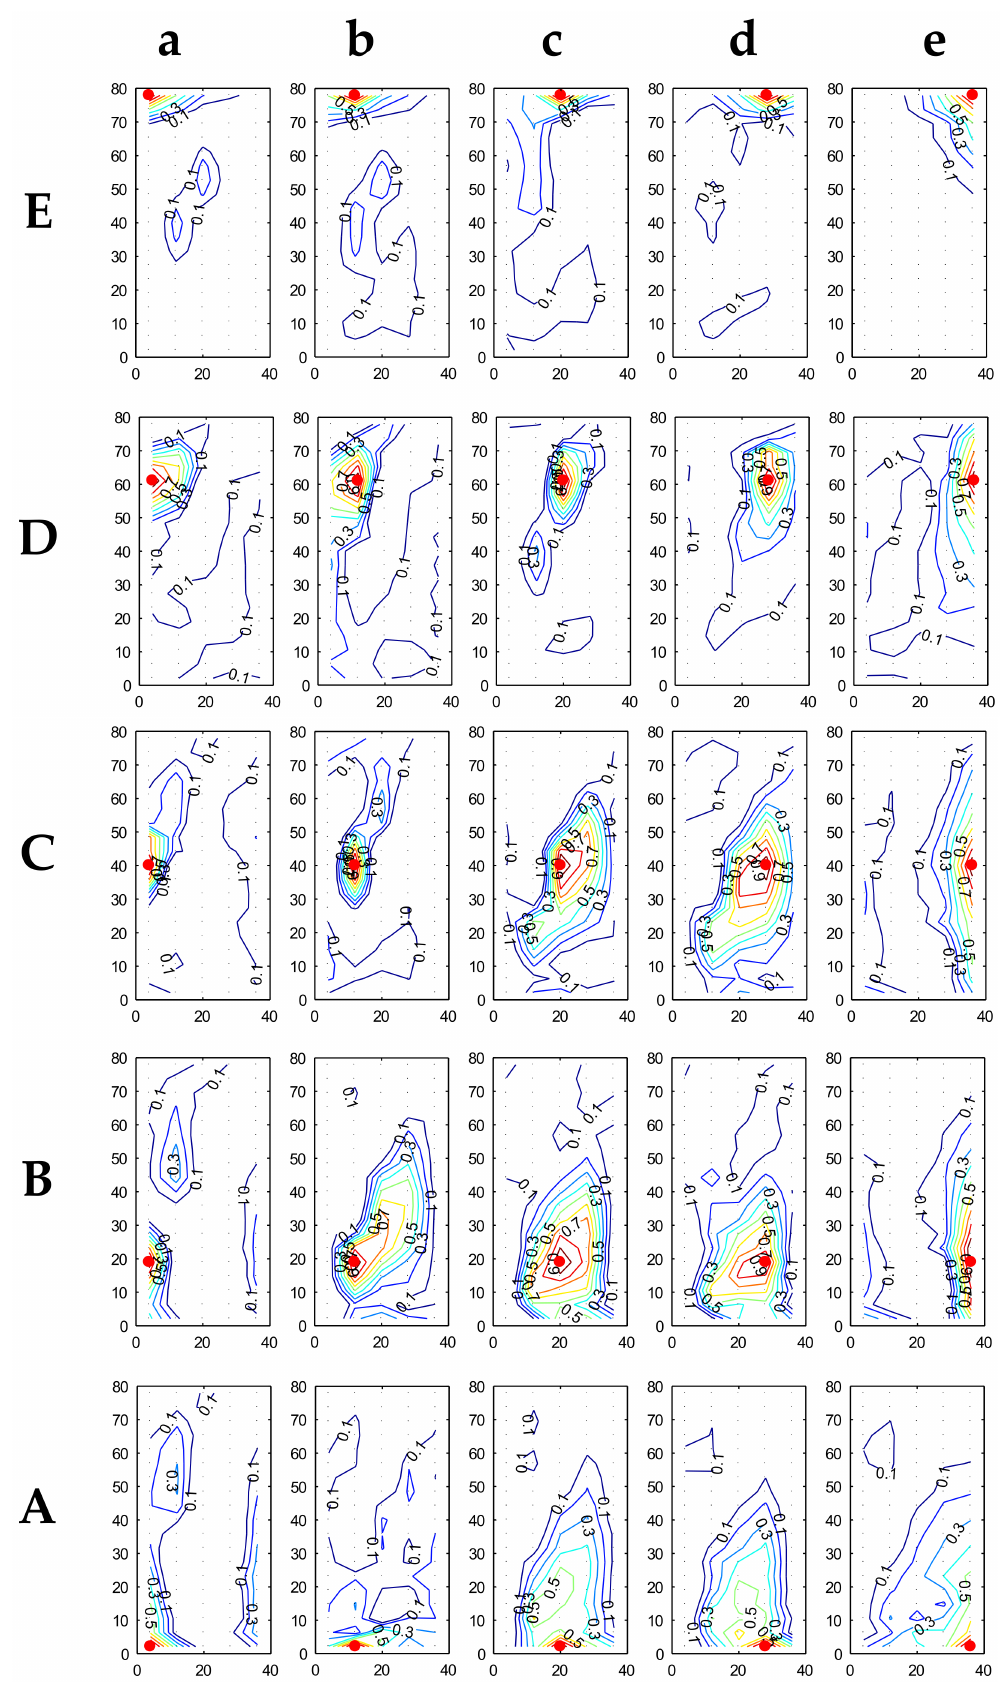
Figure 12. Correlation coefficient trend for RHF at 45 ◦ . Color bar as in Figure